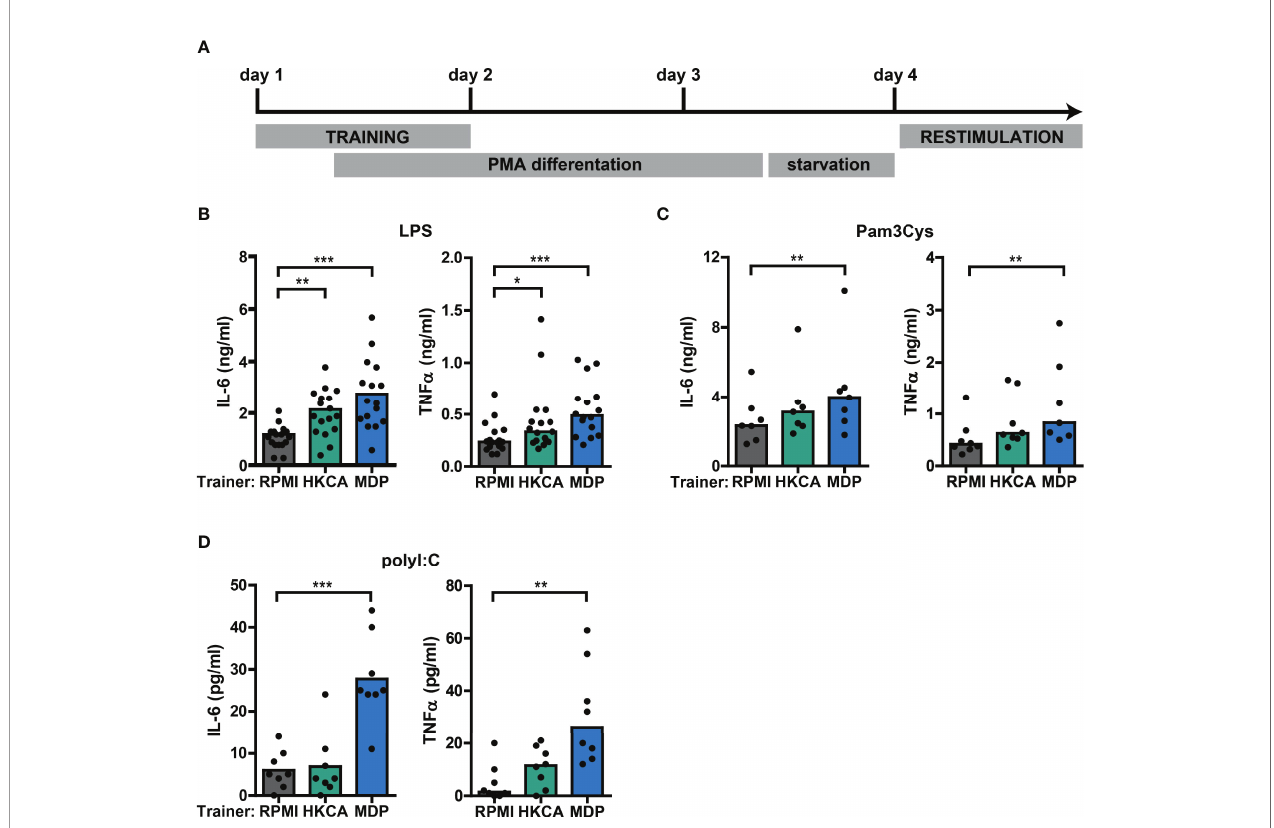
FIGURE 2 | Training with Candida albicans and MDP prompts elevated cytokine responses in THP-1 cells. (A) Schematic overview of in vitro THP-1 cell model for trained immunity. (B-D) Concentrations of IL-6 or TNF a quanti fi ed by ELISA in culture supernatants of THP-1 cells trained with heat-killed Candida albicans (HKCA; 10 6 cells/mL), muramyl dipeptide (MDP; 50 µg/mL) or RPMI and re-stimulated with (B) 50 ng/mL LPS, (C) 10 µg/mL Pam3Cys, or (D) 5 µg/mL poly I:C for 24 hours. Symbols represent the average of triplicates. Depending on the data distribution, bars represent means or medians and Friedman test or repeated measures ANOVA were performed to compare groups. *p<0.05, **p<0.01,